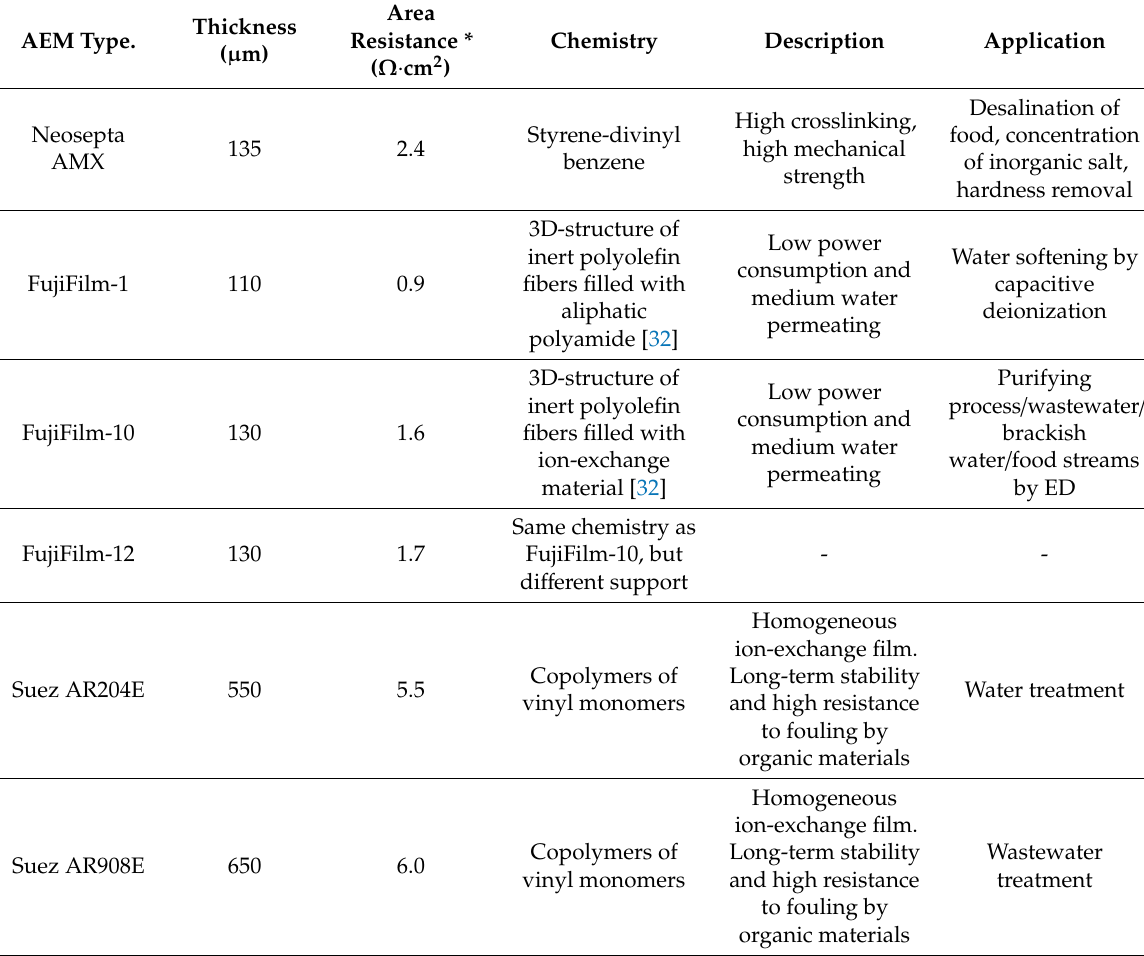
Table 2. Summary of chemical and physical properties of the six anion exchange membranes (AEMs) investigated as reported by the